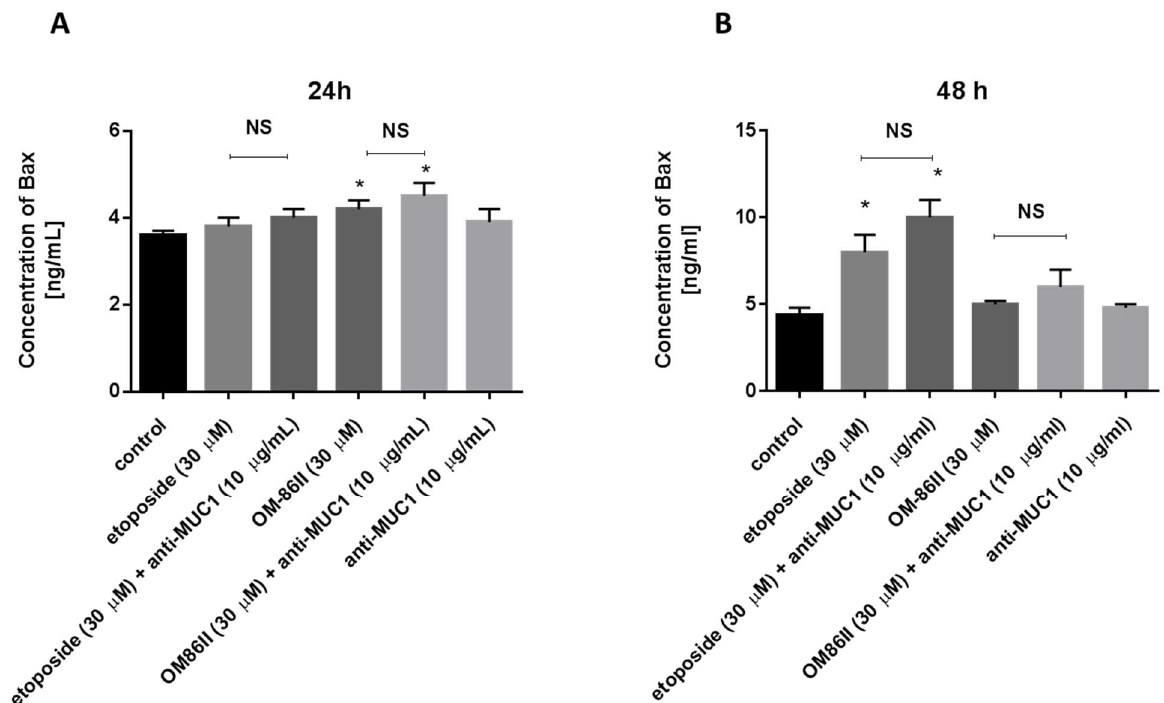
Figure 11. The concentration of pro-apoptotic Bax in human gastric cancer AGS cells after 24 h ( A ) and 48 h ( B ) of incubation with anti-MUC1 (10 µ g/mL), OM-86II (30 µ M), OM-86II + anti-MUC1 (30 µ M + 10 µ g/mL), etoposide (30 µ M) and etoposide + anti-MUC1 (30 µ M + 10 µ g/mL). Data are presented in ng/mL. * p < 0.05 vs. control group; MUC1, mucin-1; OM-86II, octahydropyrazin[2,1-a:5,4-a′]diisoquinoline derivative; ns, not significant.